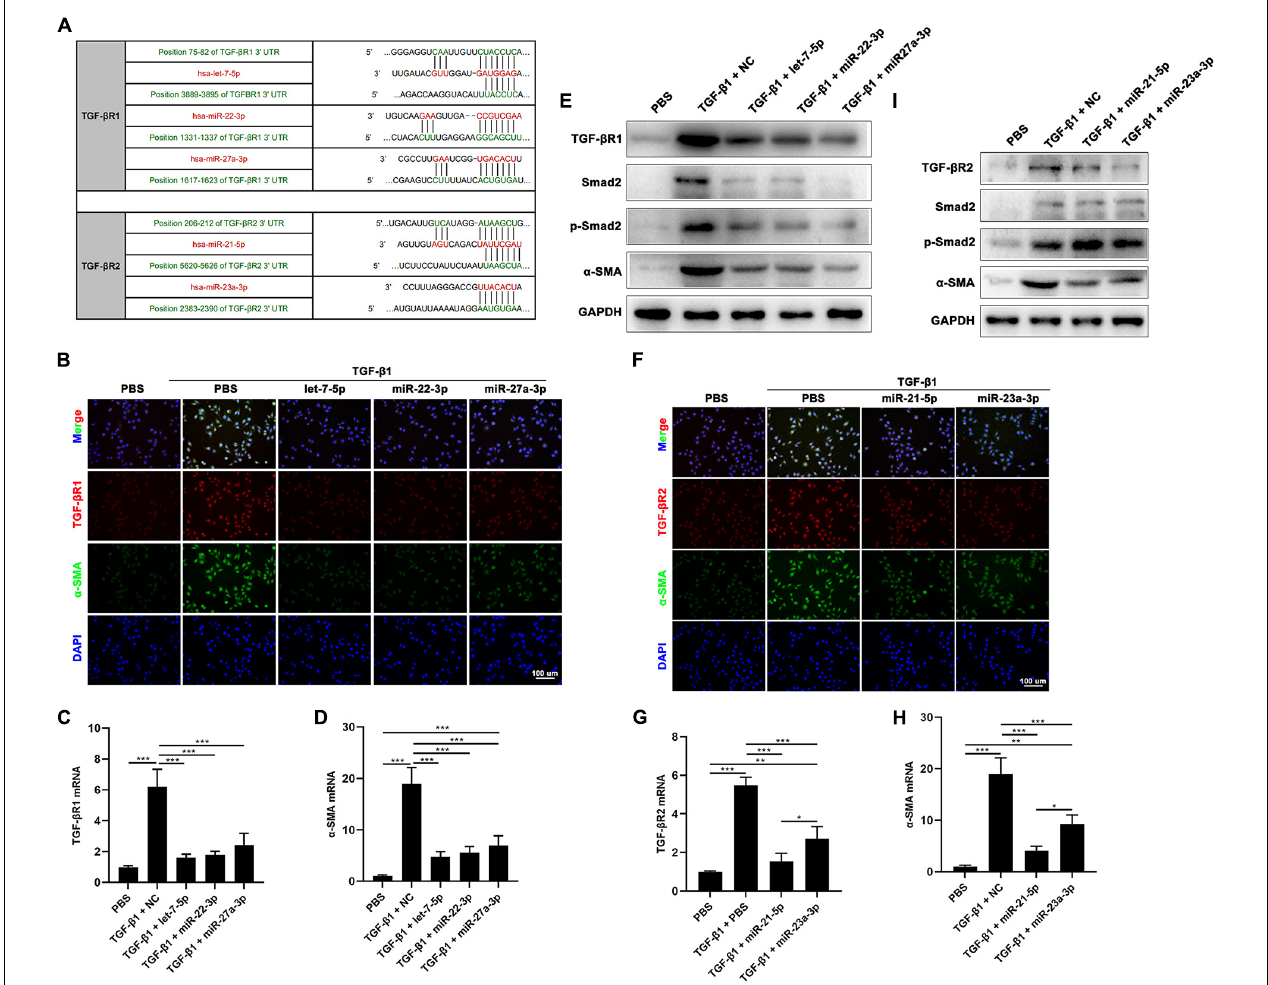
FIGURE 8 | hAFSC-exo-miRNAs target the TGF- β R1 and TGF- β R2 to suppress myofibroblast formation. (A) List of predicted binding sites for hAFSC-exo-miRNAs and their targets. (B–D) Expression levels of α -SMA and TGF- β R1 in HDFs treated with specific mimics, including let-7-5p, miR-22-3p, and miR-27a-3p. (E) Western blot analysis of TGF- β R1, Smad2, p-Smad2, and α -SMA in HDFs treated with specific mimics, including let-7-5p, miR-22-3p, and miR-27a-3p. (F–H) Expression levels of α -SMA and TGF- β R2 in HDFs treated with specific mimics, including miR-21-5p and miR-23a-3p ( scale bar = 100 µ m). (I) Western blot analysis of TGF- β R2, Smad2, p-Smad2, and α -SMA in HDFs treated with specific mimics, including miR-21-5p and miR-23a-3p. Mean ± SD; * P < 0.05; ** P < 0.01; *** P < 0.001; n =